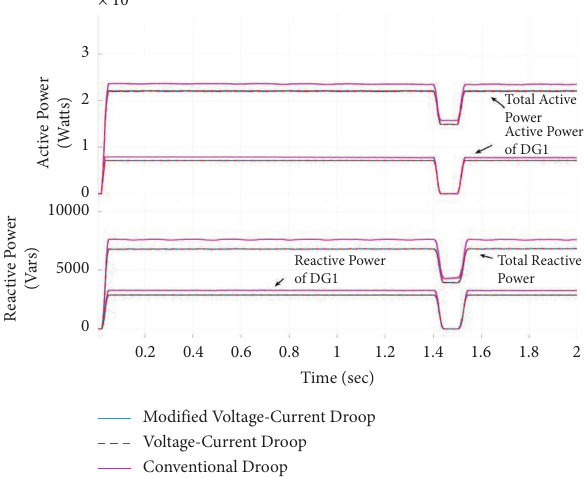
Figure 23: Scenario of power during contingency